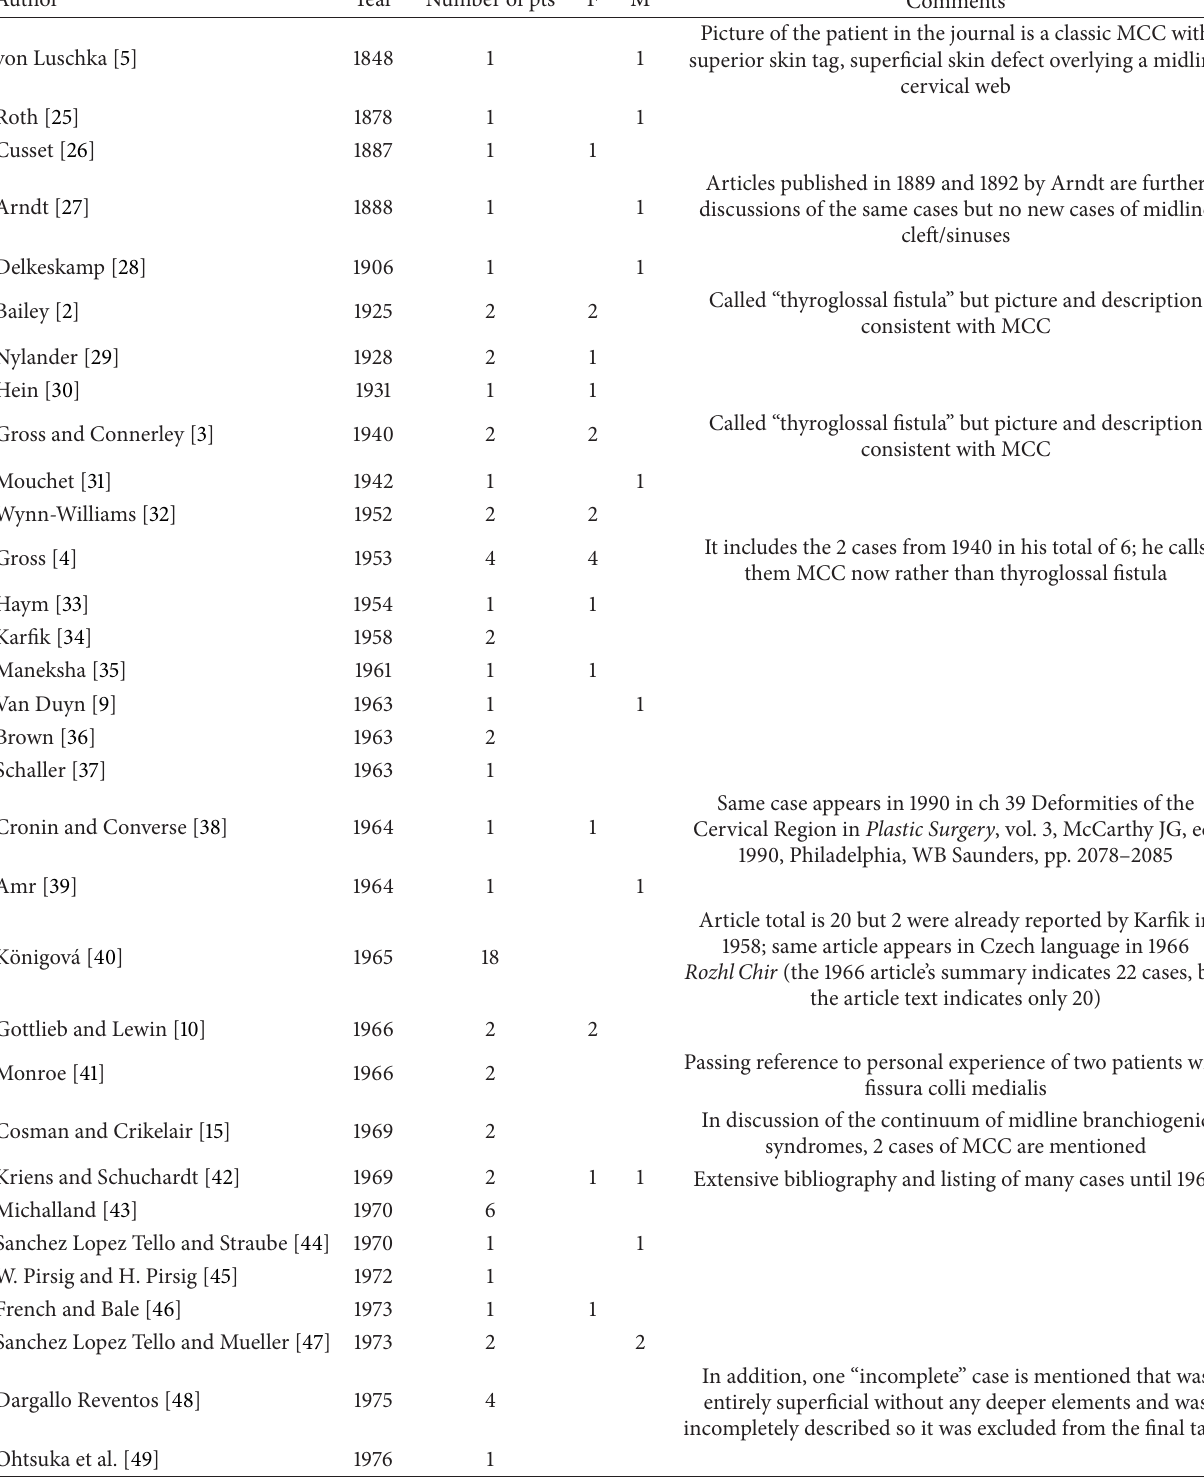
Table 1: Catalogue of the published world literature by author and